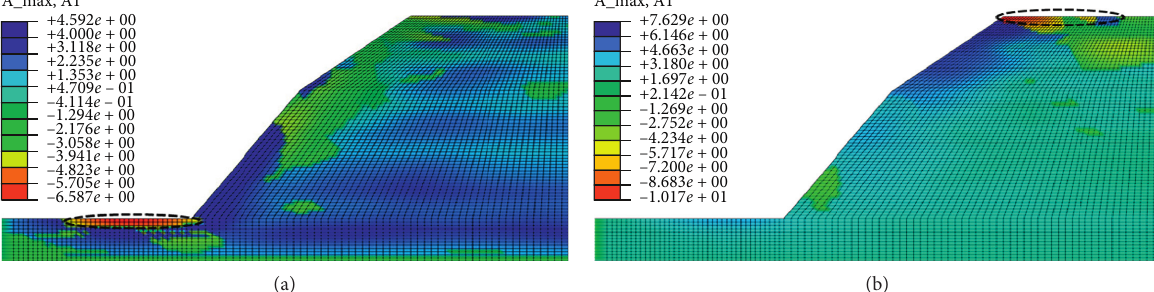
Figure 10: Horizontal acceleration contour map under different seismic excitations. (a) under Minxian seismic excitation. (b) under Tianshui seismic excitation.